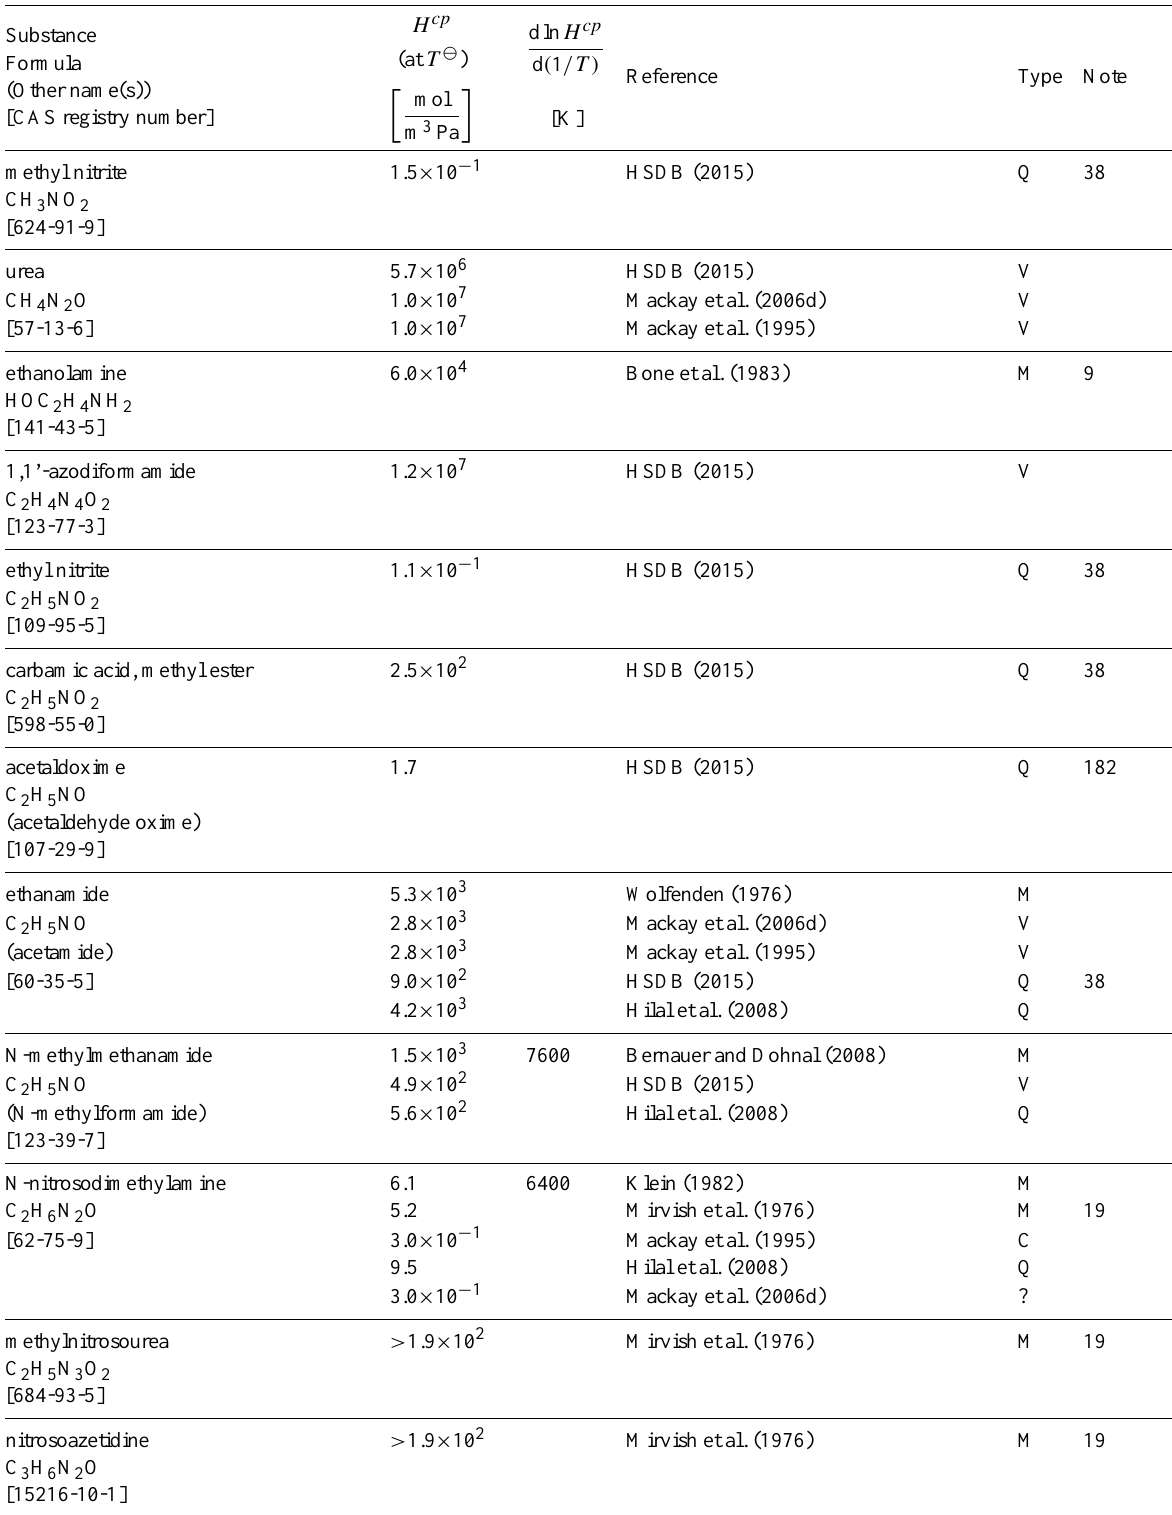
Table 6: Henry’s law constants for water as solvent